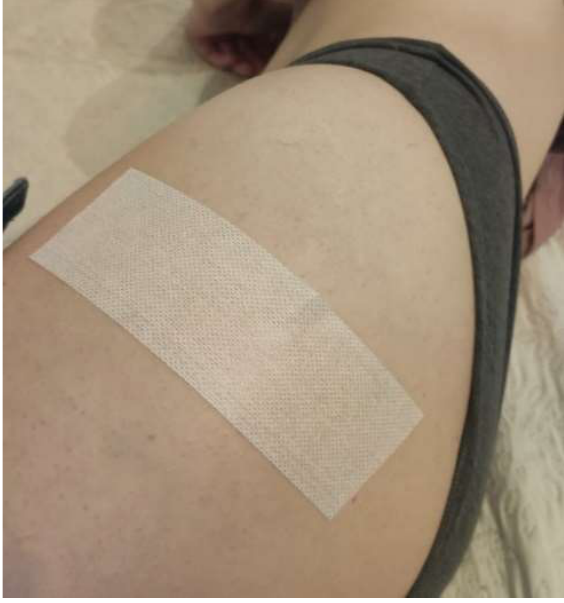
Figure 4. The method of placebo tape application used.